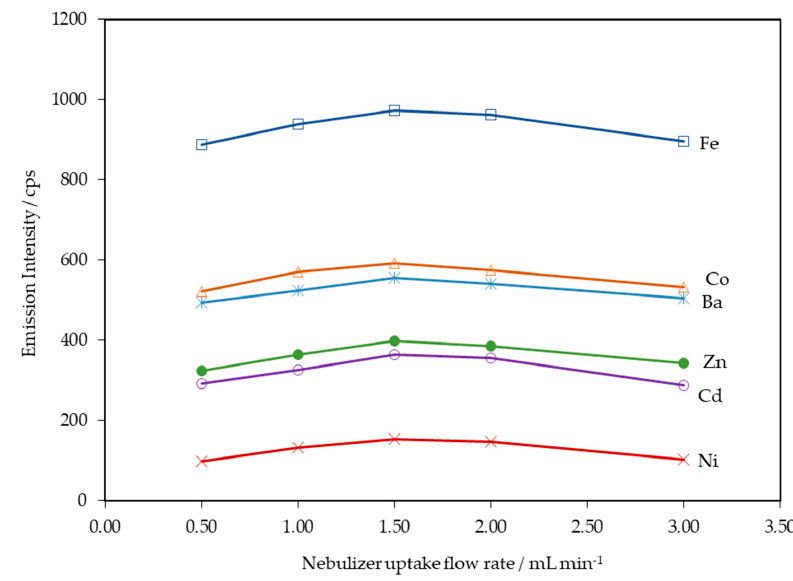
Figure 2. Effect of nebulizer gas flow rate on the emission intensity of 0.5 mg L − 1 Fe, Co, Ba, Zn, Cd, and Ni. All other parameters are presented in the text.